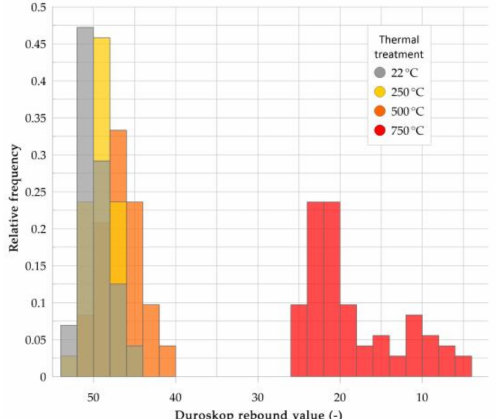
Figure 10. Histogram of Duroskop rebound values, the surface hardness of specimens.